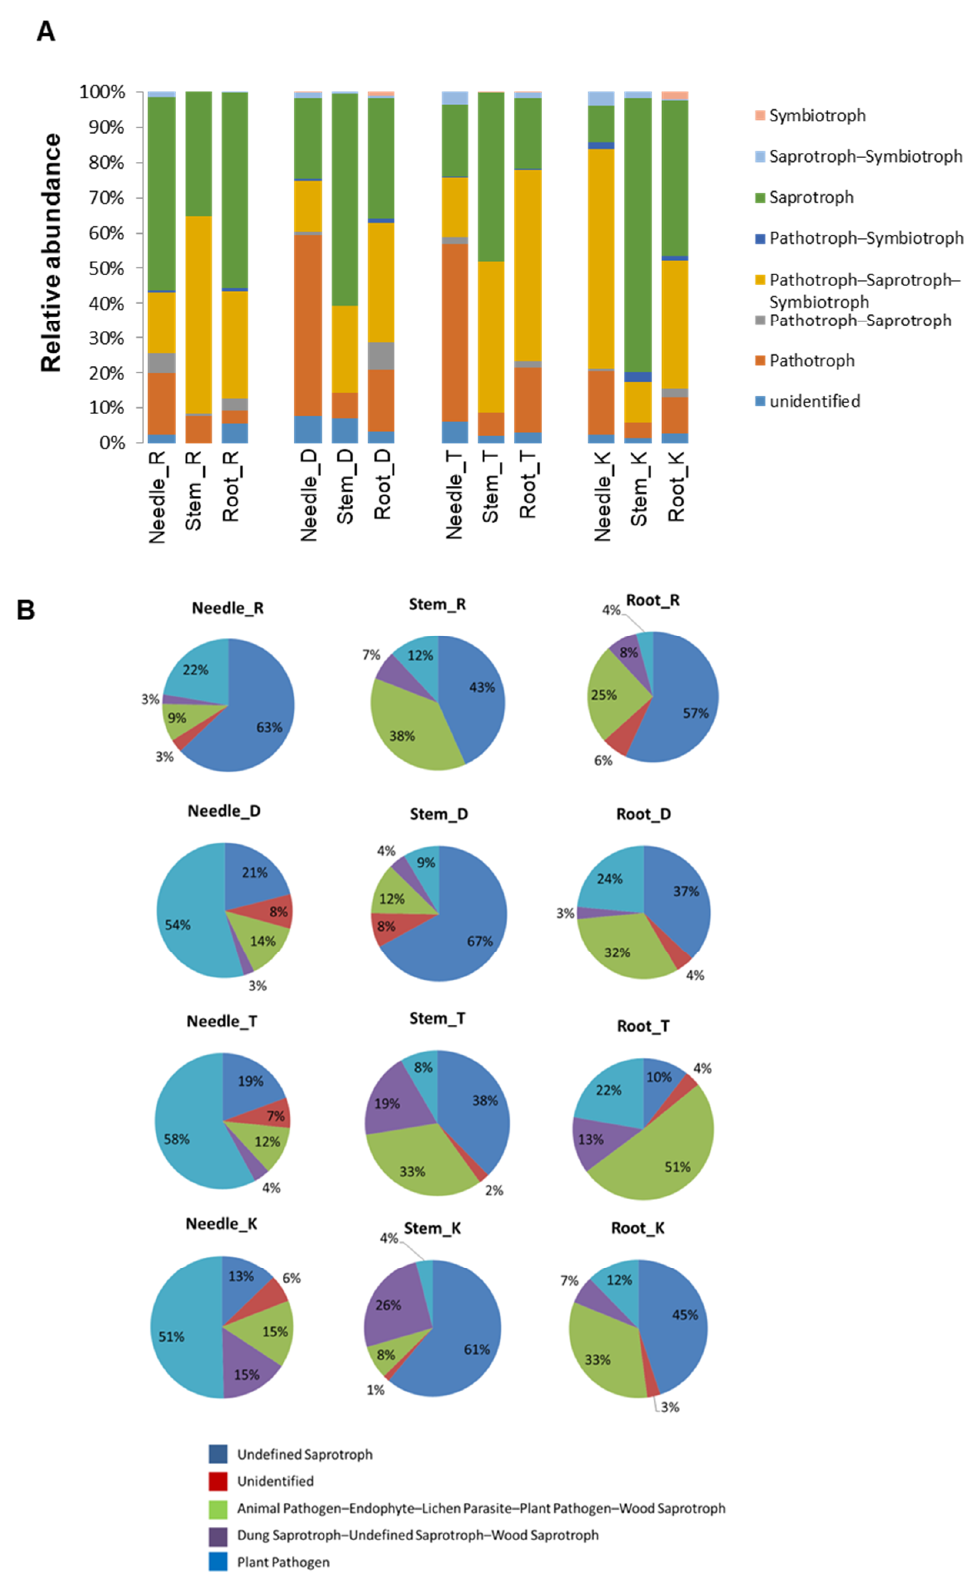
Figure 7. Relative abundance of predicted functional fungal endophytes. ( A ) Relative abundance of fungal trophic modes in needle, stem and root of the four Pinus species. ( B ) Relative abundance of fungal guilds in needle, stem and root of the four Pinus species. More data are supplied in Supplementary Figures S3 and S4.